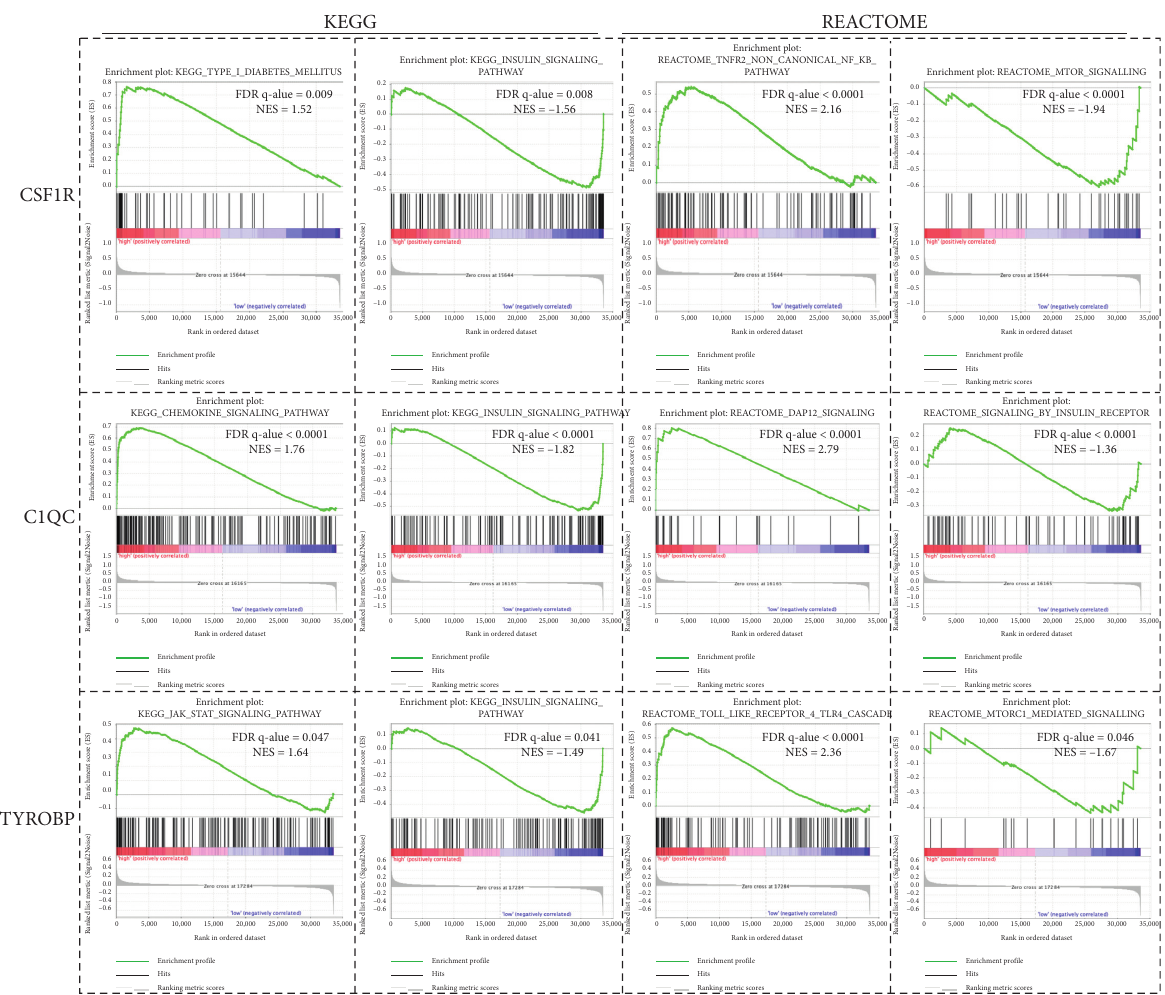
Figure 5: Gene set enrichment analysis between each hub gene’s high and low expression samples. GSEA analyzing gene-expression signatures of datasets on the basis of each gene’s high and low expression by using KEGG pathway gene sets and Reactome pathway gene